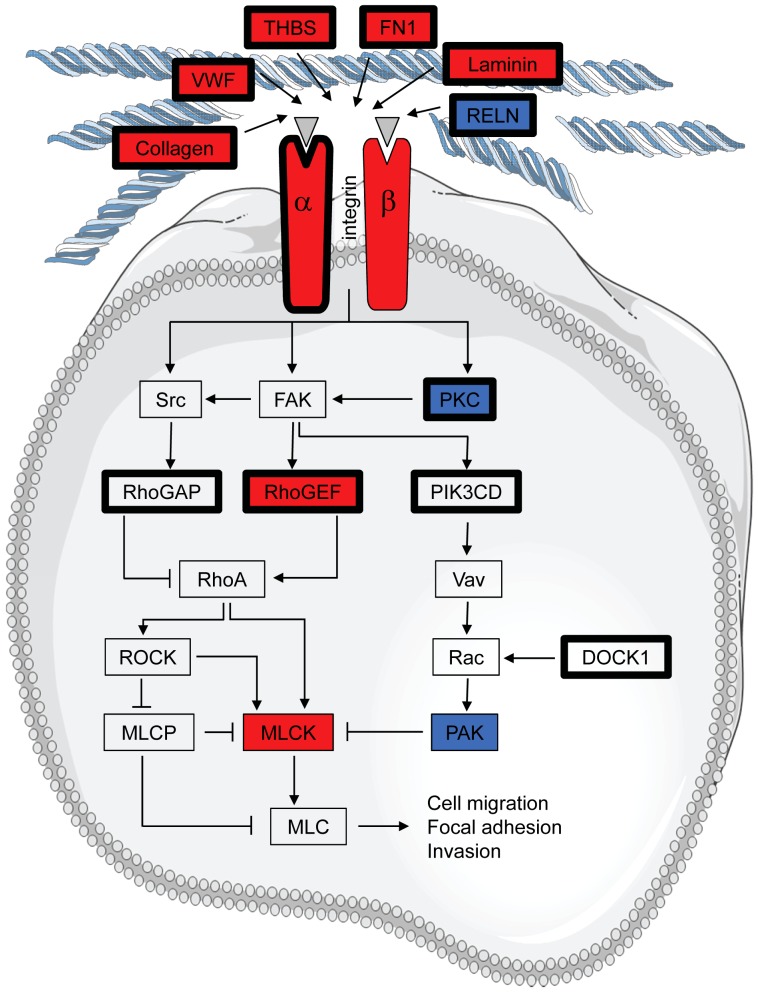
Alterations in the pathway converging on overexpression of Myosin Light Chain Kinase in C4-2B cells.Alterations are defined as having an increased (red) or decreased (blue) expression in C4-2B compared to LNCaP or by somatic mutations in C4-2B cells only (bold black lines). Overexpression of myosin light chain kinase in C4-2B cells might distinguish them from LNCaP cells in cell migration and focal adhesion characteristics.